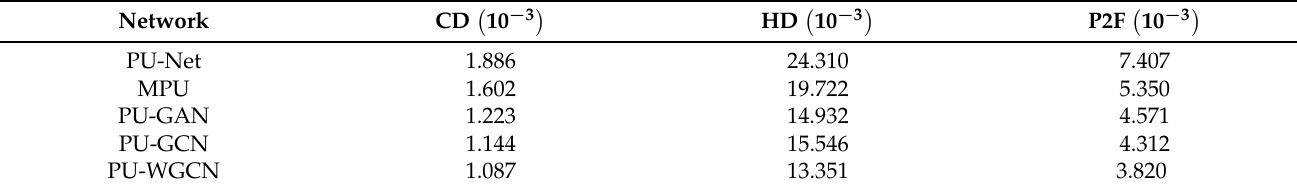
Table 3. Comparison of upsampling results for point cloud numbers from 1024 to